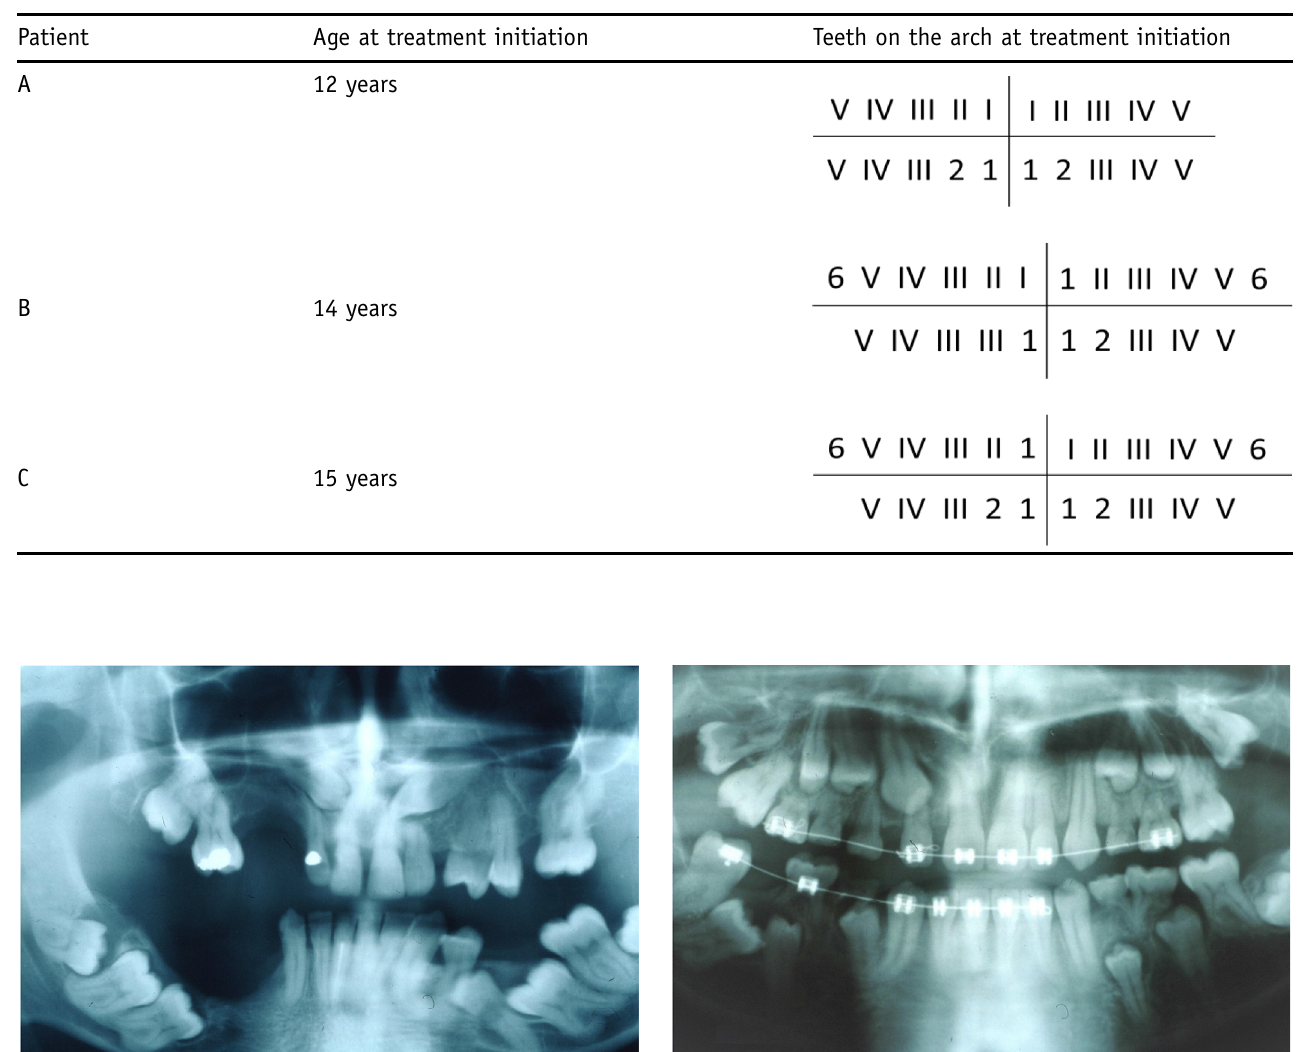
Table I. Age of patients and teeth on the arch at the beginning of treatment (temporary teeth are presented in Roman numerals, and permanent teeth are presented in Arabic numerals).